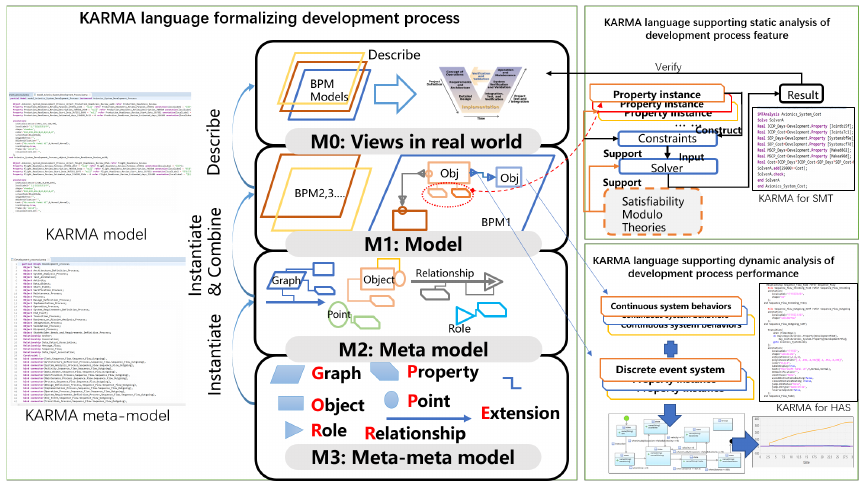
Figure 2. KARMA formalism and analysis for the development process